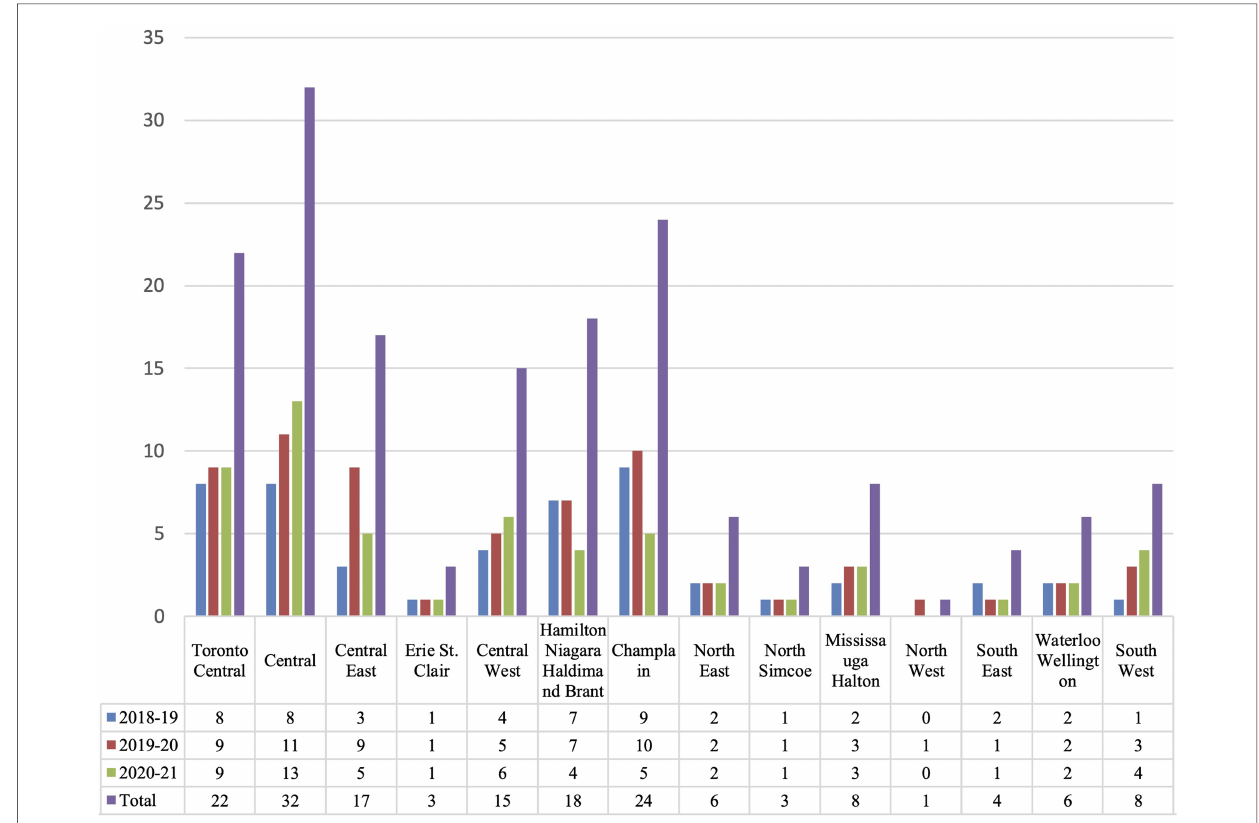
FIGURE 1 ECHO Ontario Autism participants by LHIN ( n ). Demographic information of ECHO Autism participants across all three cycles (2018 – 2019, 2019 – 2020, 2020 – 2021) by number of participants ( n ) from each Local Health Integration Network, including: (1) Toronto Central ( n =22), (2) Central ( n =32), (3) Central East ( n =17), (4) Erie/St. Clair ( n =3), (5) Central West ( n =15), (6) Hamilton/Niagara/Haldimand/Brant ( n =18), (7) Champlain ( n =24), (8) North East ( n =6), (9) North Simcoe ( n =3), (10) Mississauga/Halton ( n =8), (11) North West ( n =1), (12) South East ( n =4), (13) Waterloo/Wellington ( n =6), and (14) South West ( n